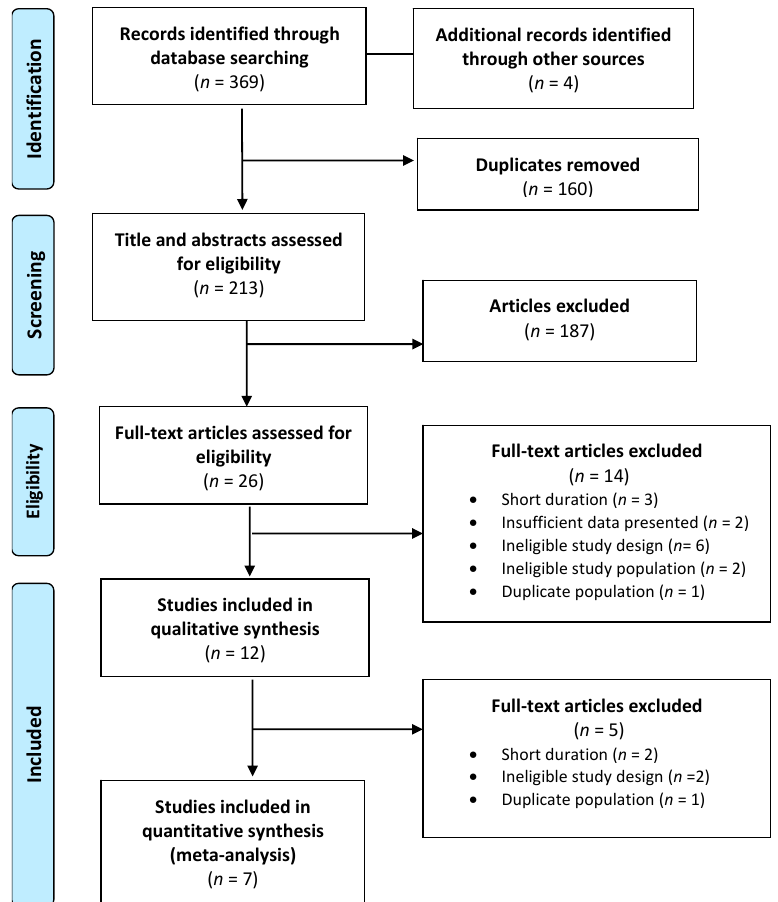
Figure 1. PRISMA flow diagram of study selection.